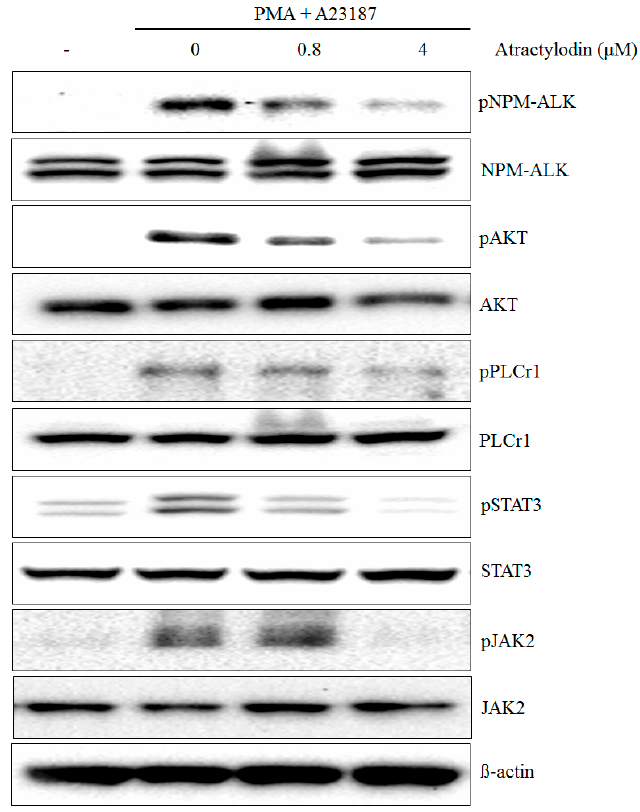
Figure 2. ( D ) HMC-1 was treated with the indicated concentrations of Atractylodin for 0.5 h prior to being incubated with PMA (50 nM) plus A23187 (1 μ M) for 0.5 h and phospho and total NPM-ALK, AKT, PLC γ 1, JAK2, and STAT3 were detected by immunoblot analysis as described in Materials and Methods.